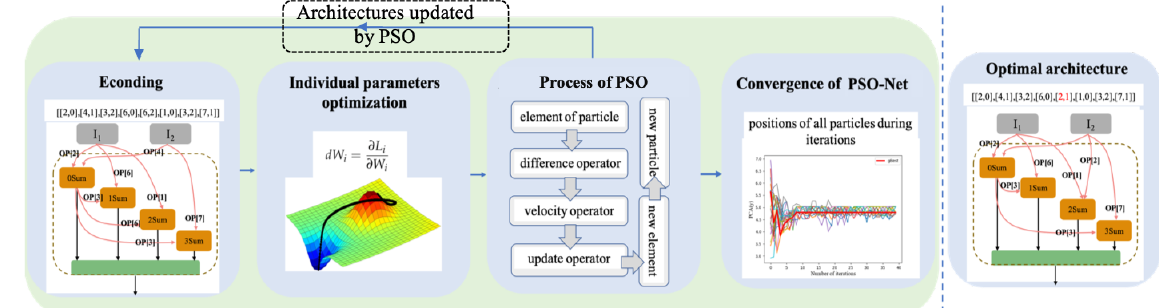
Figure 1. Framework of the stages of particle swarm optimization PSO-Net. The constructed network architectures from the search space are encoded into arrays, and populations are initialized. The gradient descent method is used to obtain the weight parameters for all architectures separately, and PSO is used to optimize the architectures and to search for the optimal architecture until reaching the number of iterations. The output is the optimal architecture.